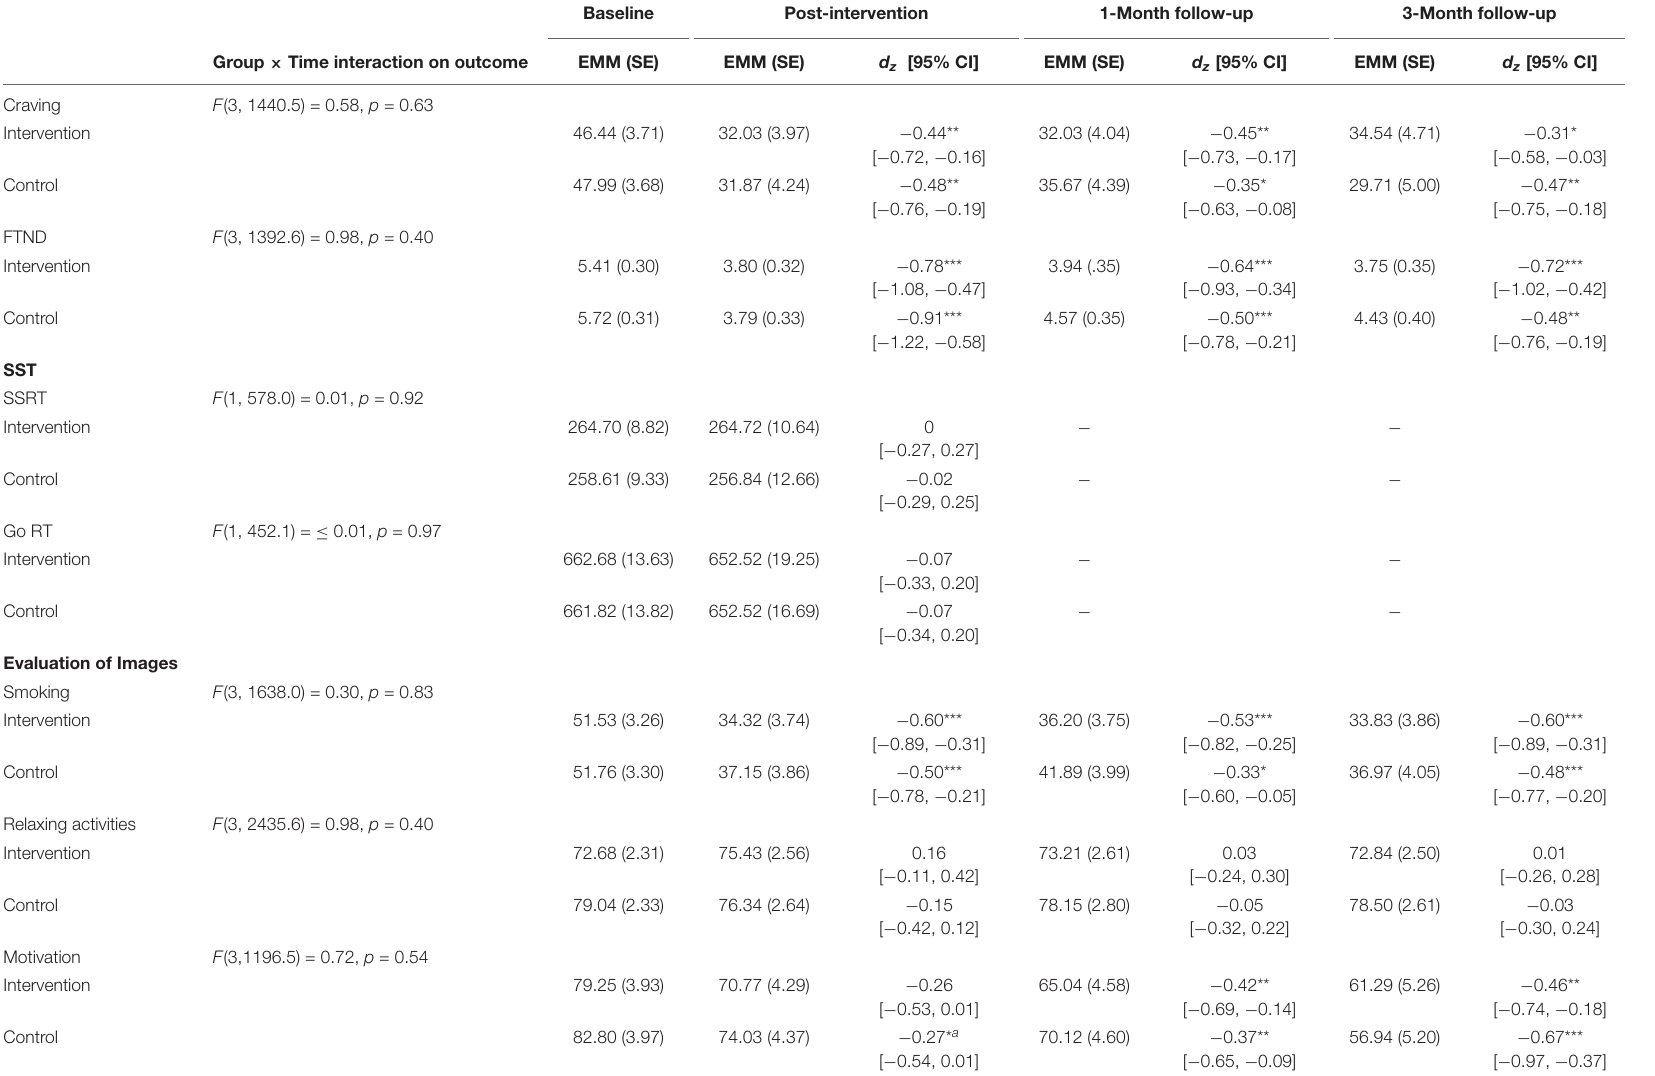
TABLE 2 | Estimated marginal means (EMM) and standard errors (SE) of each secondary outcome by group over time. Baseline Post-intervention 1-Month follow-up 3-Month